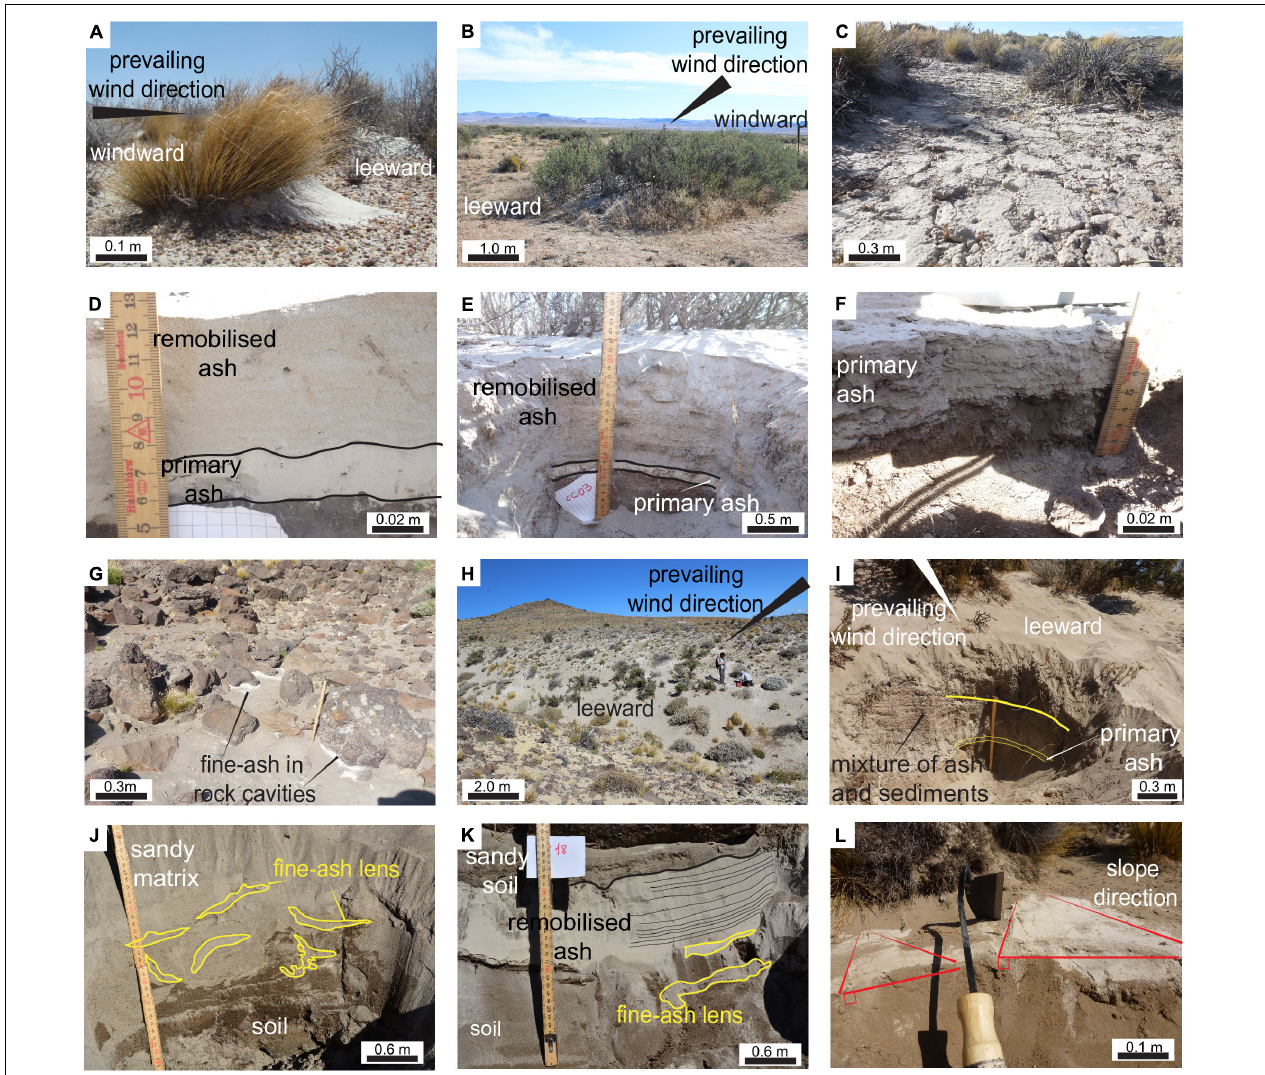
FIGURE 5 | Remobilisation deposits: (A) Deposit on the leeward side of an herbaceous steppe plant ( poa ligularis ) (Photo: Juan Gaitan). (B) Leeward side deposit on bank of plants ( prosopis denudans ). (C) Interpatch surface between plants. (D) Primary and remobilised deposit on the windward side of a group of plants. (E) Primary and remobilised deposit on the leeward side of a group of plants. (F) Planar stratificated deposits within the interpatch surface. (G) Accumulations of very fine ash in cavities between rocks. (H) Overview of the leeward side of a large bedform. (I) Remobilised deposits on the leeward side of a mound. (J) Fine-ash lenses embed in a sand-ashy matrix. (K) Cross stratified layer of remobilised ash intercalated with fine-ash lenses. (L) Accumulation of very fine-ash on the slopes of a